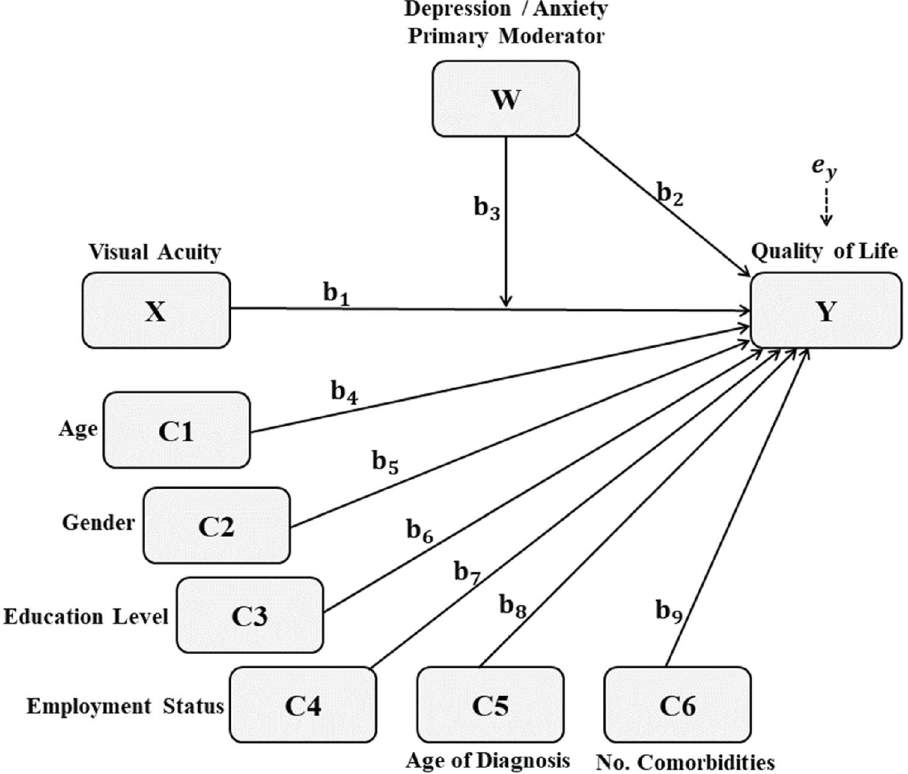
Figure 1. Moderation model for the relationship between visual acuity and quality of life, with anxiety or depression as moderators, and age, gender, education level, employment status, age of diagnosis and number of comorbidities as covariates.